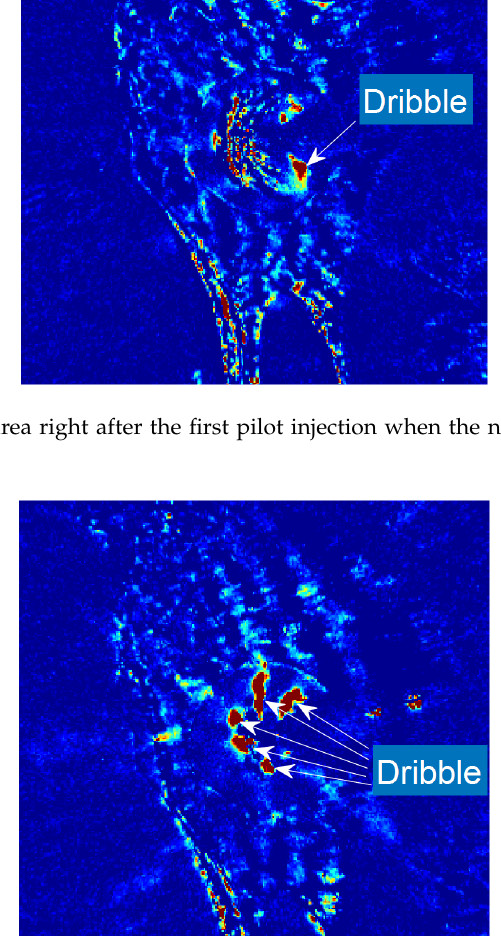
Figure 10. Near nozzle area right after the first pilot injection when the aged injector is used, with contrast enhancing.